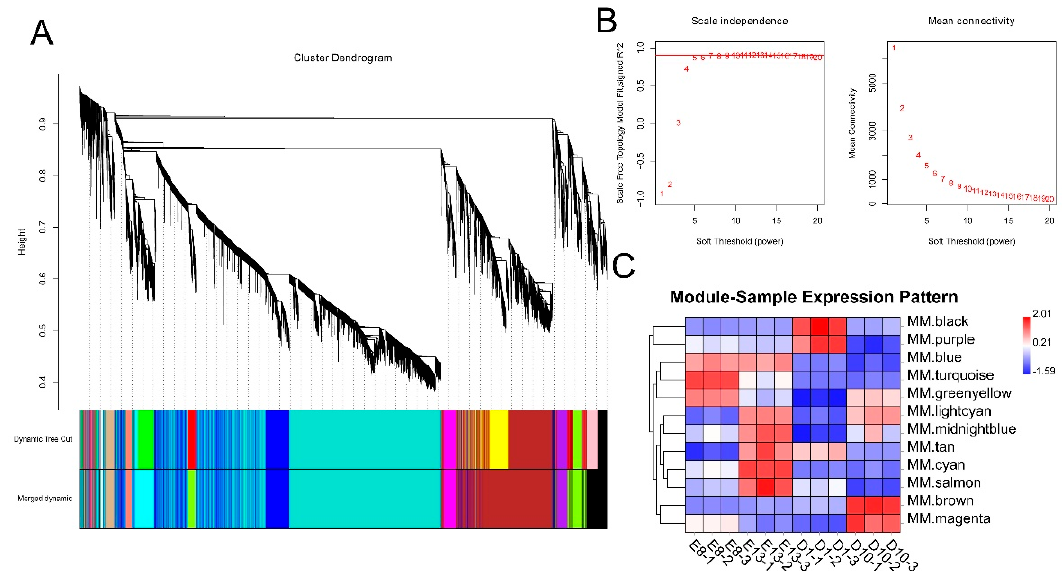
Figure 2. WGCNA analysis of DEGs. ( A ) Clustering dendrogram of DEGs with dissimilarity based on the topological overlap. Dynamic tree cutting was applied to identify modules by dividing the dendrogram at significant branch points. Modules are displayed with different colours in the horizontal bar immediately below the dendrogram. ( B ) Determination of soft − thresholding power for WGCNA analysis. The graph indicates that soft thresholding power above 5 meets scale − free topology above 0.85. ( C ) Heatmap of the correlation between samples and gene modules. Each row corresponds to a module eigengene, each column to a sample. Each cell contains the corresponding correlation value. Red and blue colours represent positive and negative correlations, respectively. The darker the colour, the higher the correlation.